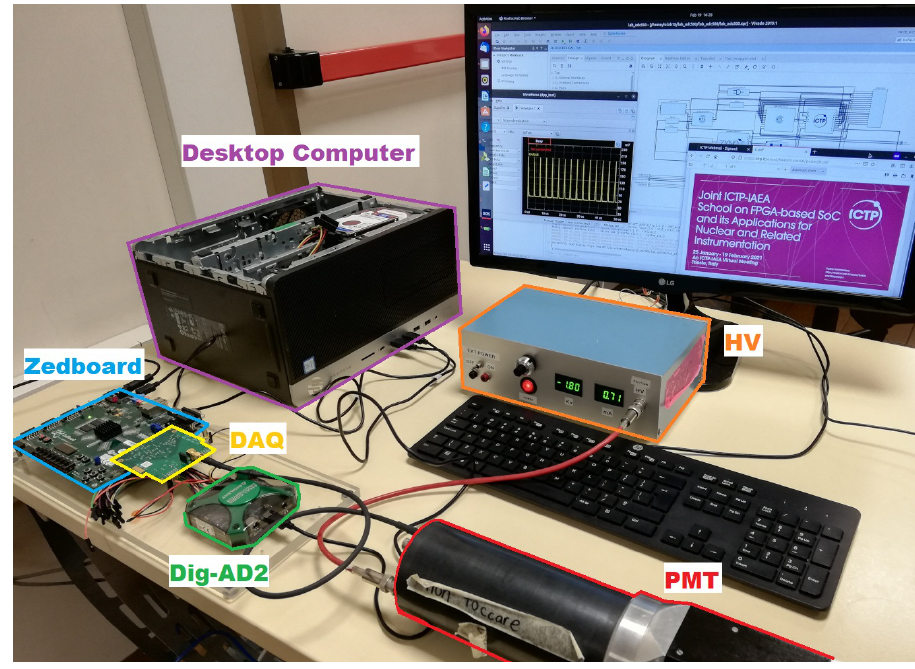
Figure 3. Experimental hardware setup for the remote laboratory.